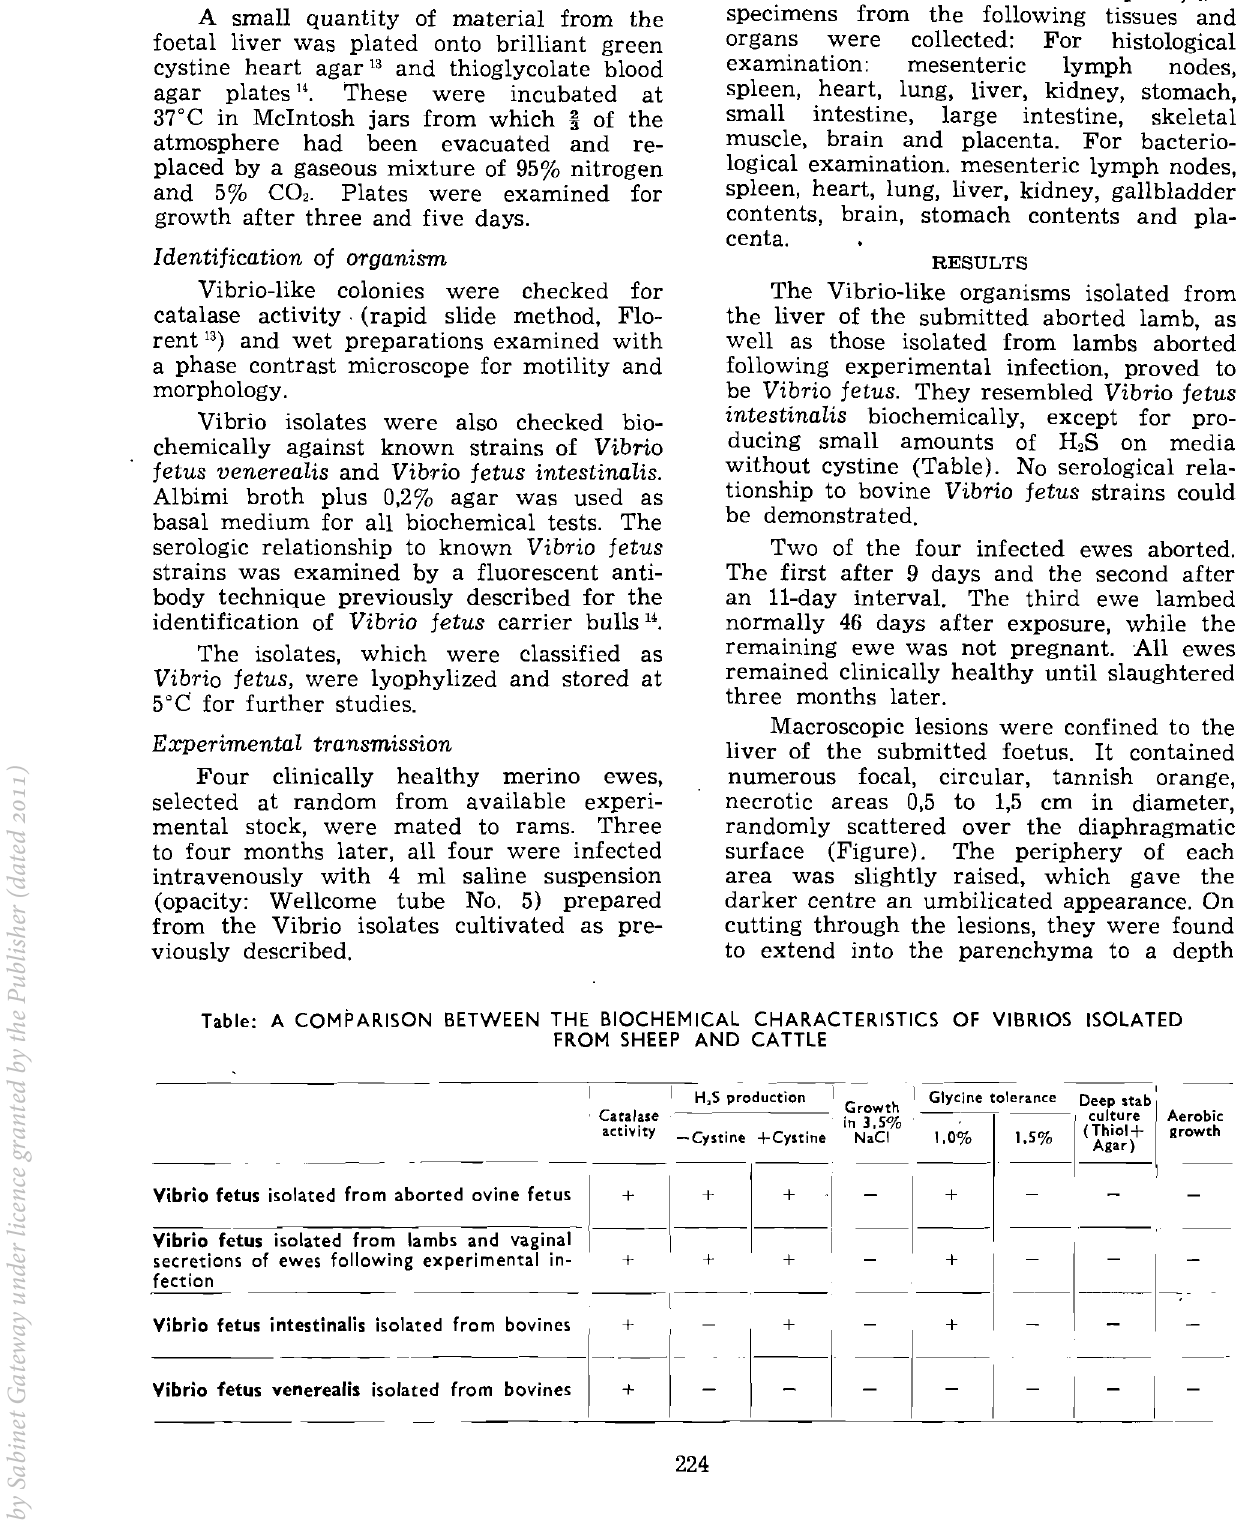
Table: A COMPARISON BETWEEN THE BIOCHEMICAL CHARACTERISTICS OF VIBRIOS ISOLATED FROM SHEEP AND